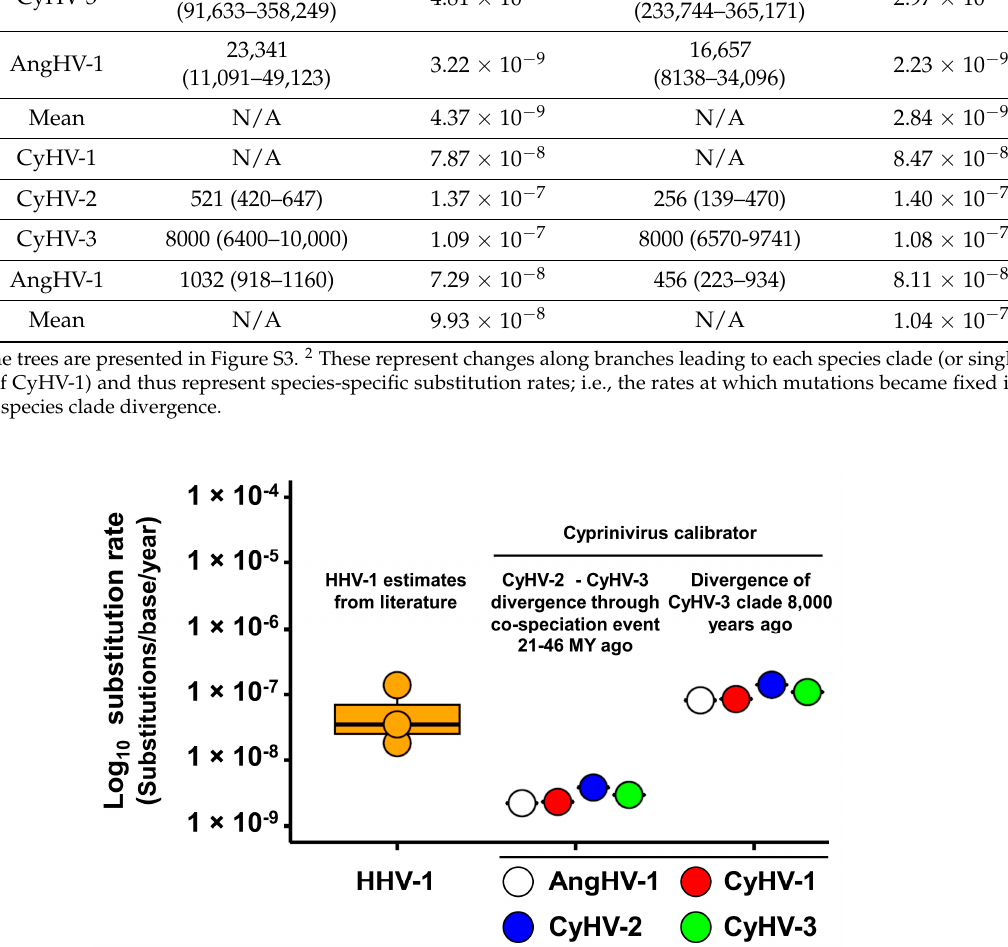
Figure 6. Comparison of species-specific nucleotide substitution rate estimates between HHV-1 and cypriniviruses. HHV-1 substitution rates were reported in the studies described in Table S9. Rate estimates for cypriniviruses were estimated based on two different calibration hypotheses. Corresponding time trees are available in Figure S3.